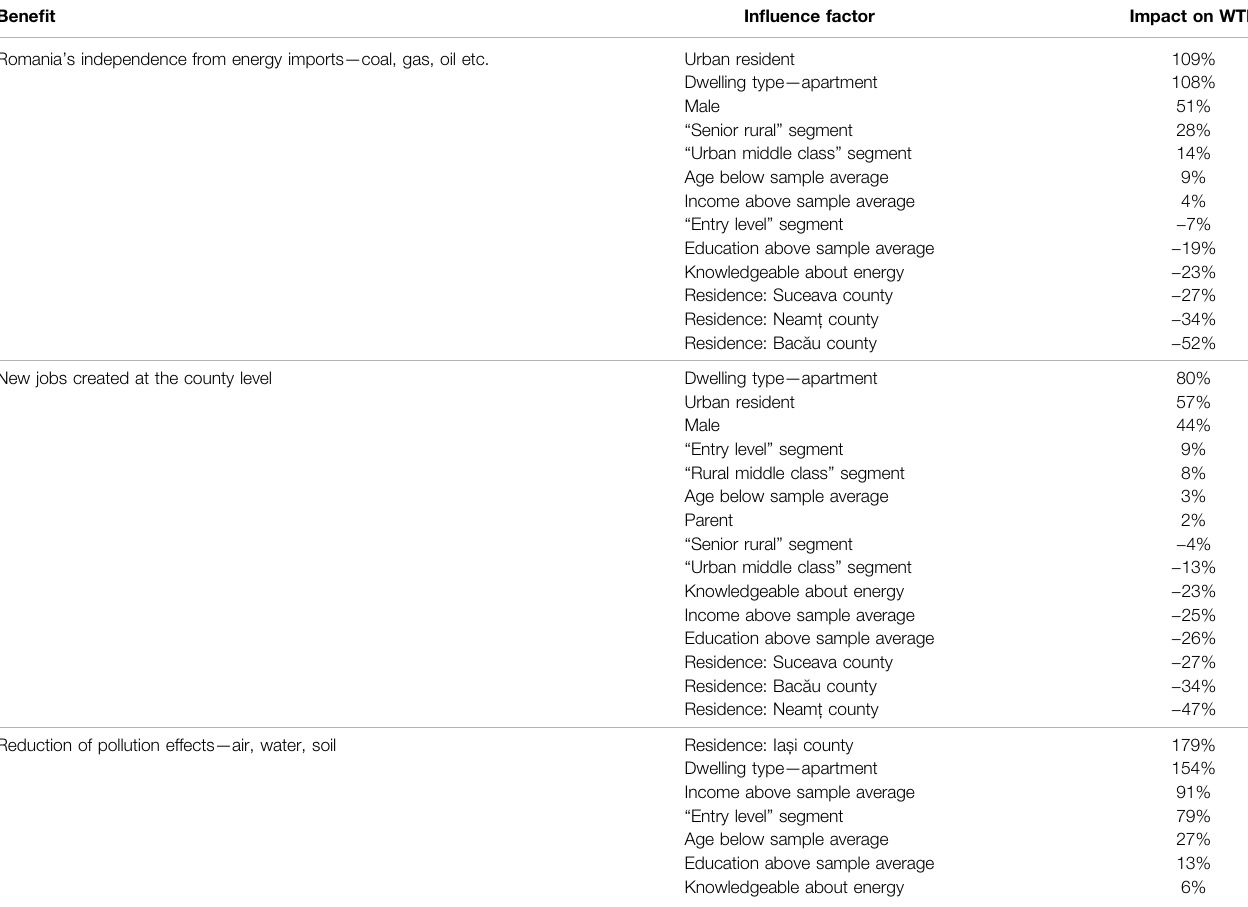
TABLE 9 | Identi fi cation of factors that have a signi fi cant in fl uence on WTP and their estimated impact. Bene fi t In fl uence factor Romania ’ s independence from energy imports — coal, gas, oil etc.